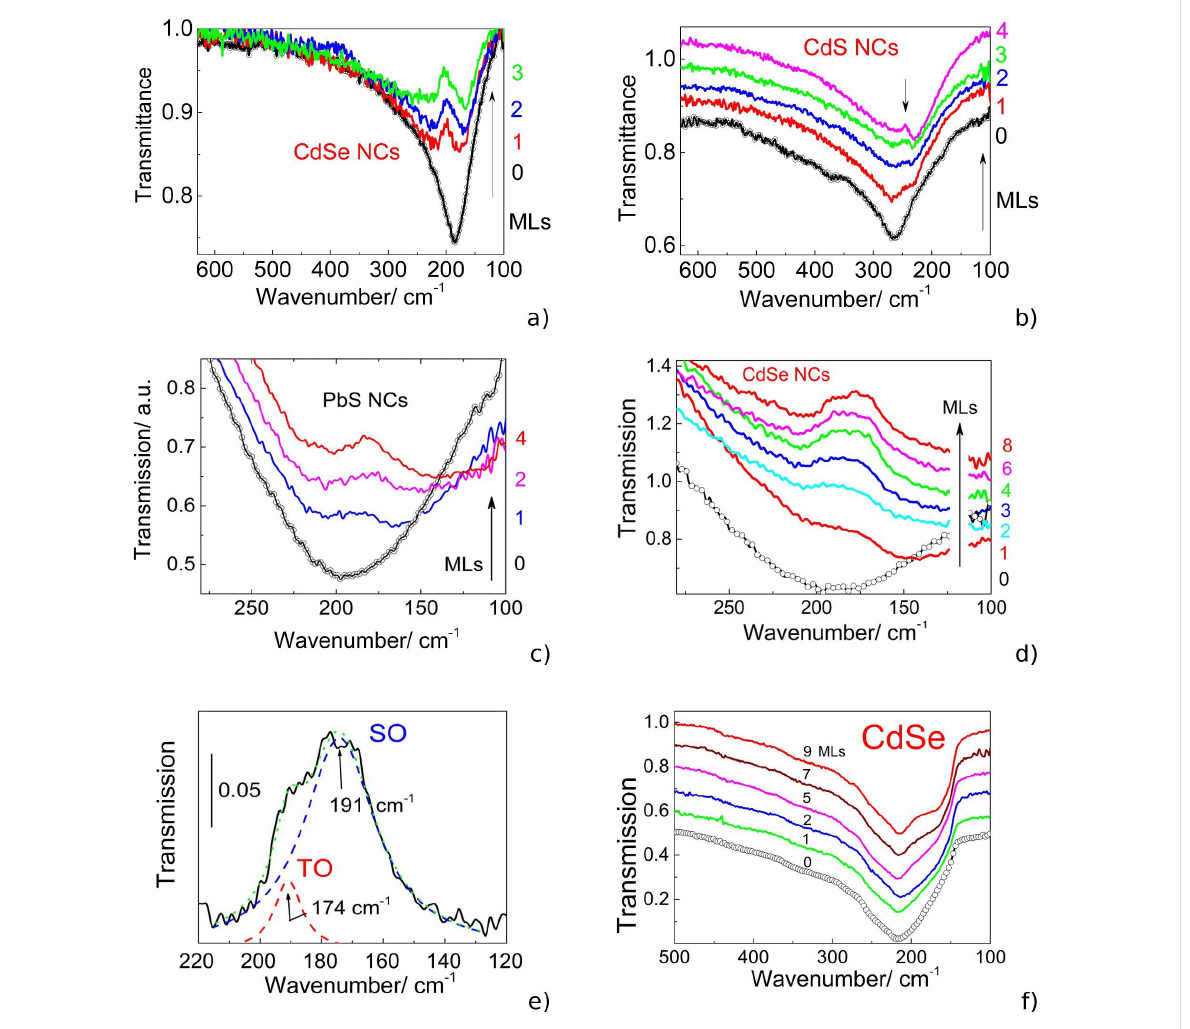
Figure 8: IR transmission spectra of the linear nanoantenna arrays before nanocrystal (NC) deposition (black circles) and after covering with different ML quantities for (a) CdSe and (b) CdS NCs. IR transmission spectra of H-shaped nanoantenna arrays before NC deposition (black circles) and after covering with different ML quantities for (c) PbS and (d) CdSe NCs. e) Fragment of the IR spectrum of 9 MLs of CdSe NCs deposited on the H-shaped nanoantenna arrays (Figure 8d, curve 8) after background subtraction. f) IR transmission spectra of microantenna arrays before NC deposi- tion (black circles) and after covering with different ML quantities for CdSe NCs. Figure 8a and 8b are reprinted with permission from [23], copyright 2017 American Chemical